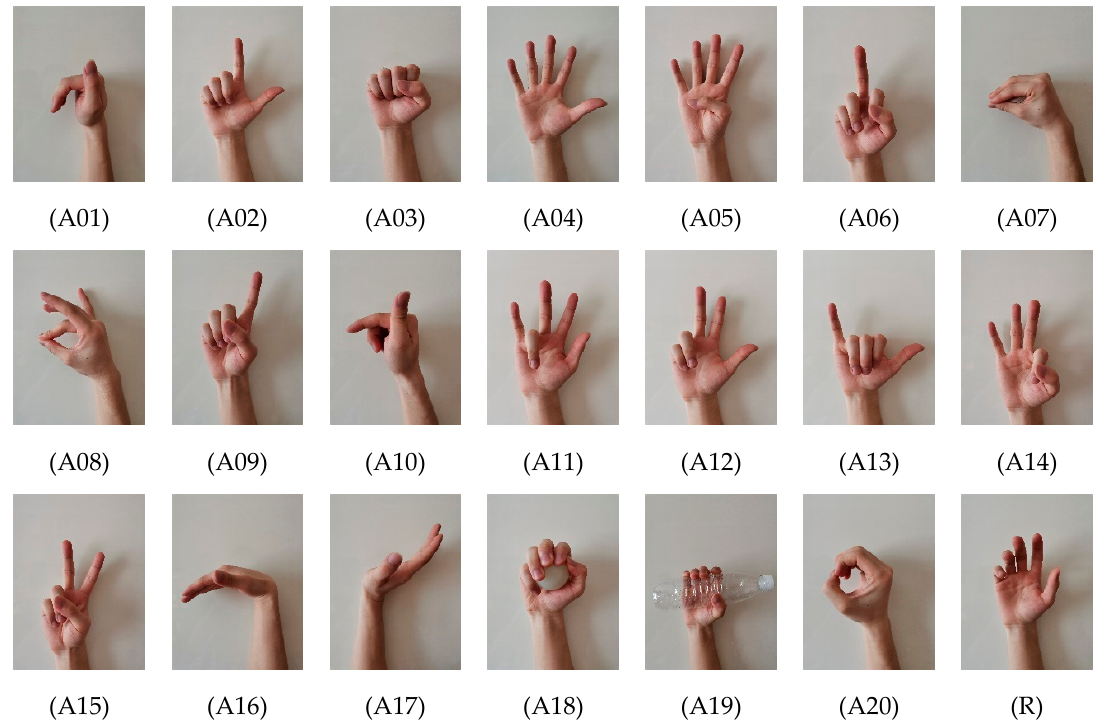
Figure 3. A01–A20 are 20 different hand gestures, and R represents the relaxation gesture. All these gestures (except R) are rapidly finished by going through a process of R-A-R within 2 seconds.